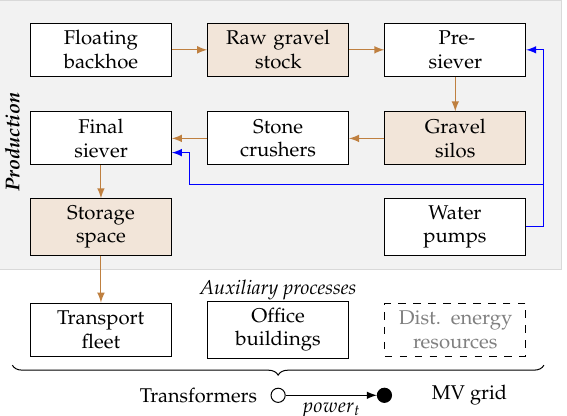
Figure 3. Internal processes of the gravel plant; brown boxes represent material storage; brown arrows represent product flows, and blue for